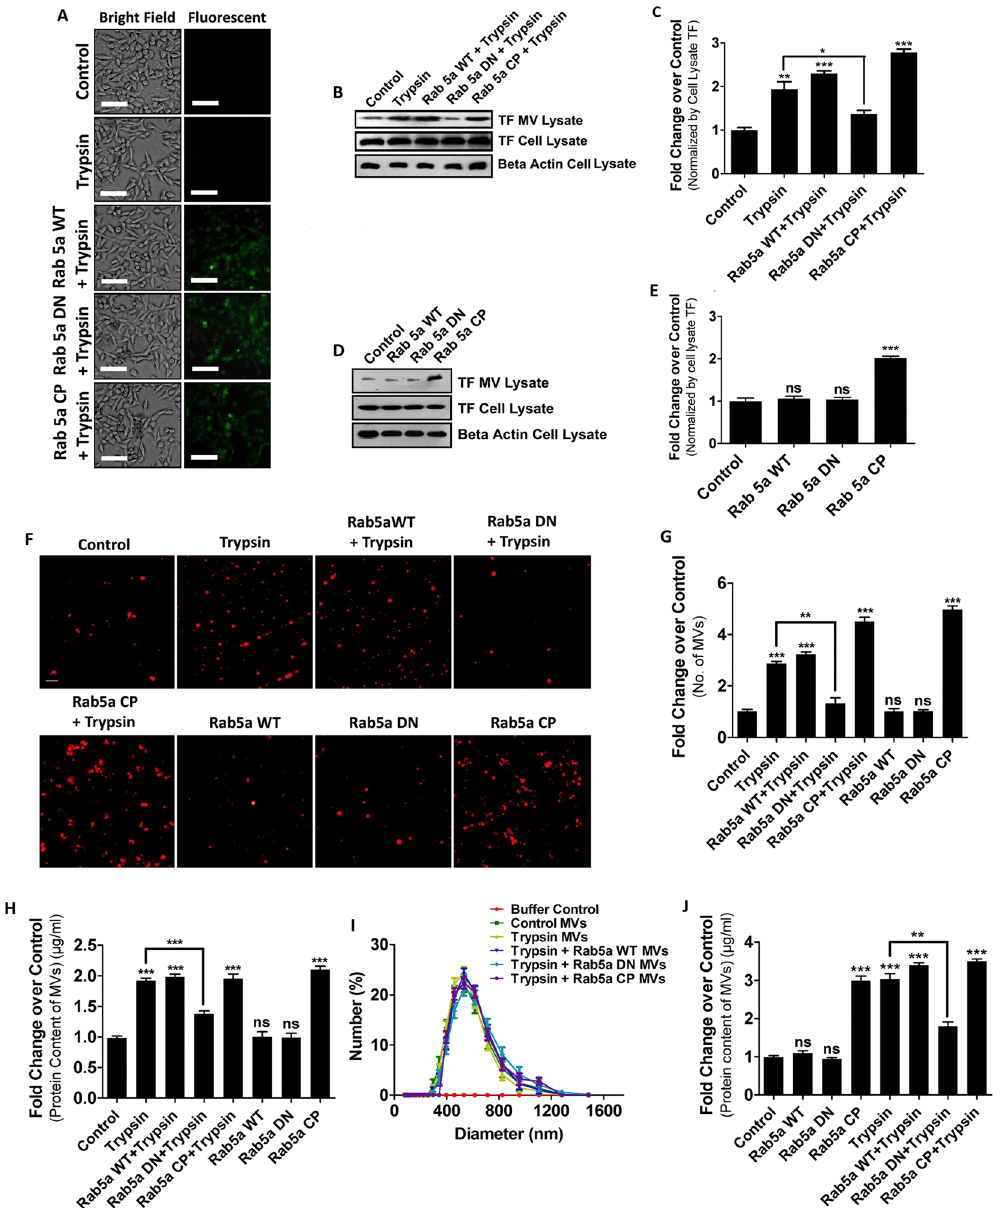
Figure 1. Trypsin Induces Microvesicles Generation from Human Breast Cancer Cells via Rab5a Activation. MDA-MB-231 cells were transfected with GFP-tagged Rab5a WT or Rab5a DN or Rab5a CP with the help of Lipofectamine 2000 ( A ). 48 hours later, cells were serum starved for 2 hours followed by treatment with trypsin (5 nM). 24 hours later, MVs were collected from the cell-supernatant and quantified by western blotting with MVs marker protein, TF and accordingly graph was prepared by GraphPad Prism5 ( B ) and ( C ). MDA-MB-231 cells were transfected with Rab5a constructs alone without trypsin addition and MVs quantification was done by western blotting ( D ) and ( E ). MVs were isolated, stained with a lipophilic dye, Nile Red and imaged by a fluorescent microscope. From the images MVs numbers were quantified and graph was generated by GraphPad Prism5 ( F ) and ( G ). MVs were lysed with lysis buffer and protein concentration was measured by Bradford assay and accordingly a comparative graphical analysis was performed by GraphPad Prism5 ( H ). MVs were suspended in 1X PBS followed by size analysis by DLS ( I ). MCF-7 cells were transfected with plasmid constructs of various Rab5a (WT, DN and CP) alongside control. After 48 hours, cells were challenged with trypsin overnight followed by MVs isolation as described in Methods. MVs were quantified by protein content analysis by Bradford assay and accordingly comparative graphical analysis was performed ( J ). Data presented over here are as Mean + / − S.E. of the Mean and differences are statistically significant at p < 0.05 using students’t-test after repeating the experiments at least